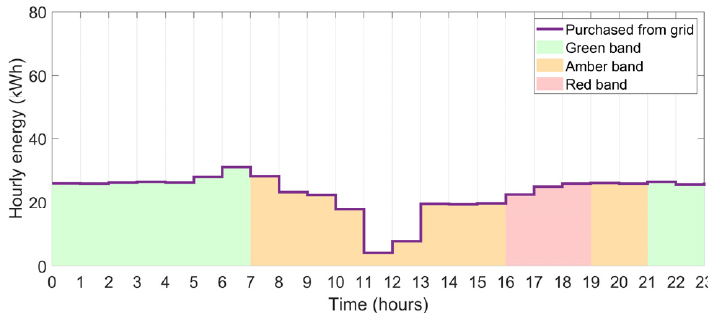
Figure 7. Hourly energy purchased from the grid for a day for scenario 1.